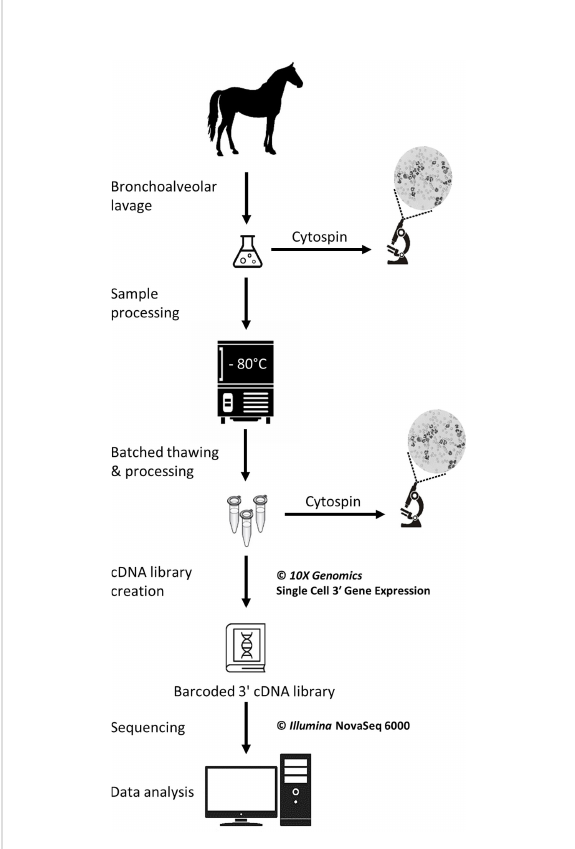
FIGURE 1 Experimental work fl ow for the single-cell mRNA sequencing of cryopreserved equine bronchoalveolar